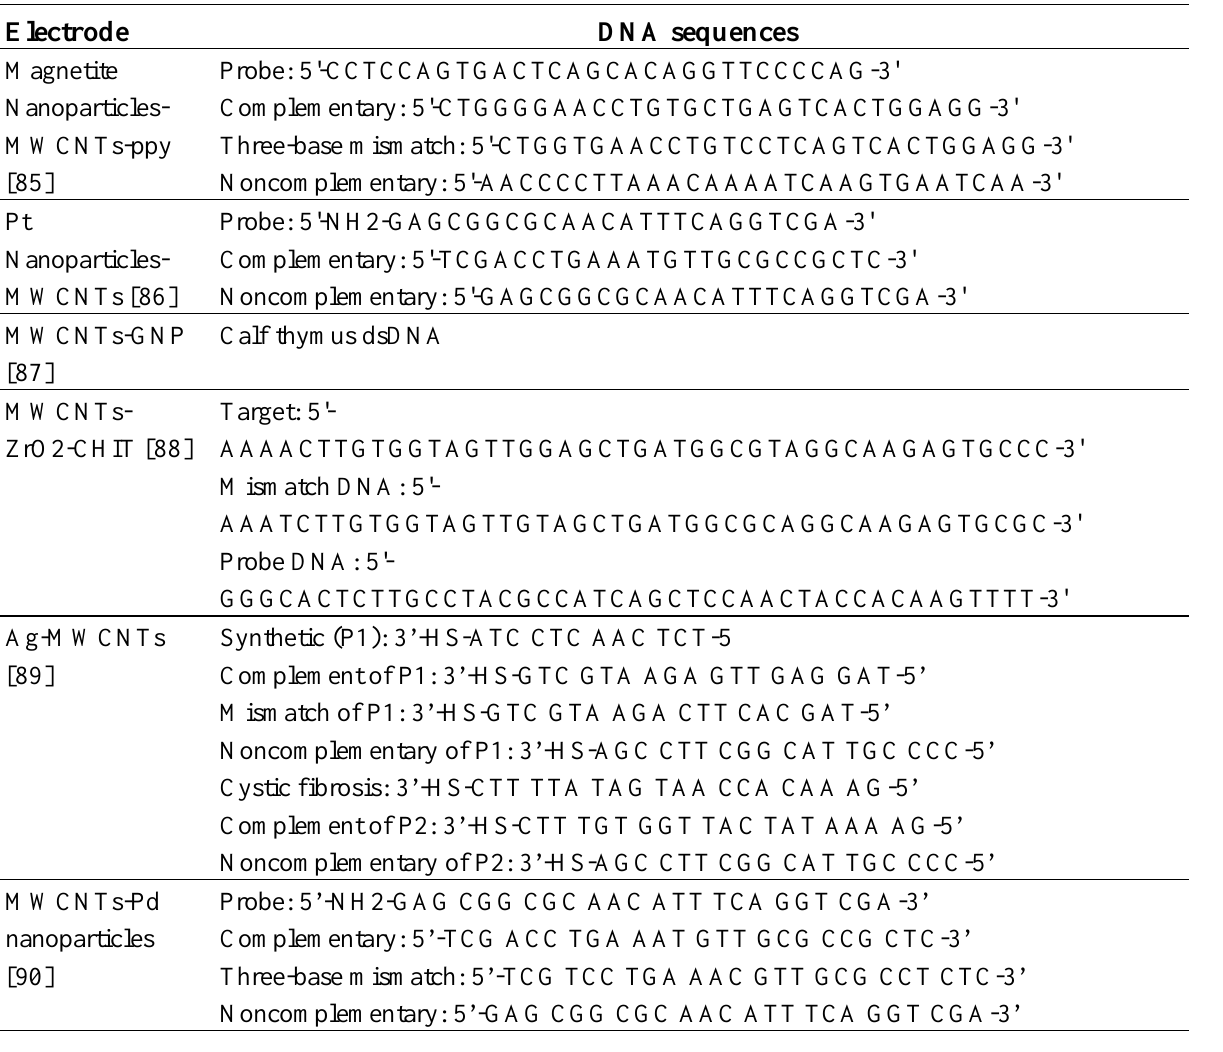
Table 1. DNA sequences studied at different modified